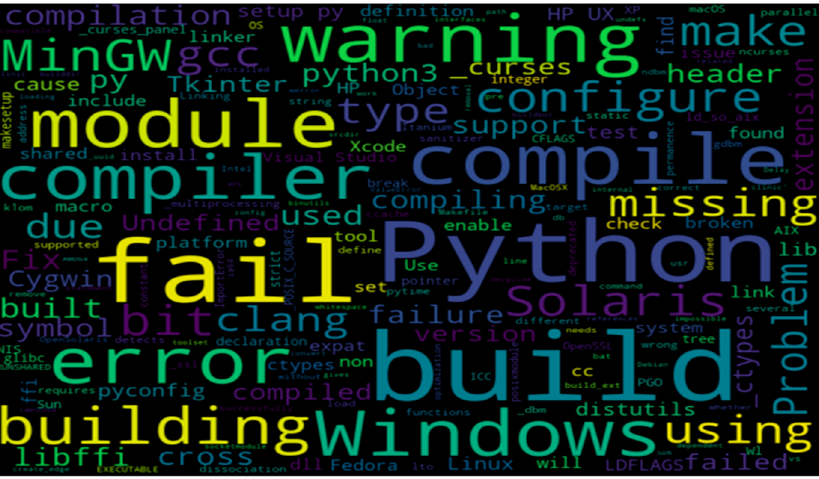
Figure 8. Word cloud of “Security”